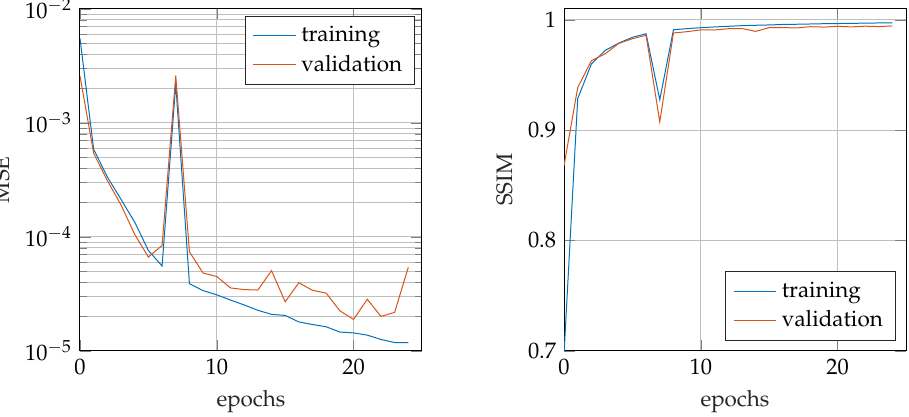
Figure 8. Visualization of training process with 60,000 data sets (48,000 training data set; 24,000 vali- dation data set) over 24 epochs. As validation parameters mean squared error (MSE) and structural similarity (SSIM) are